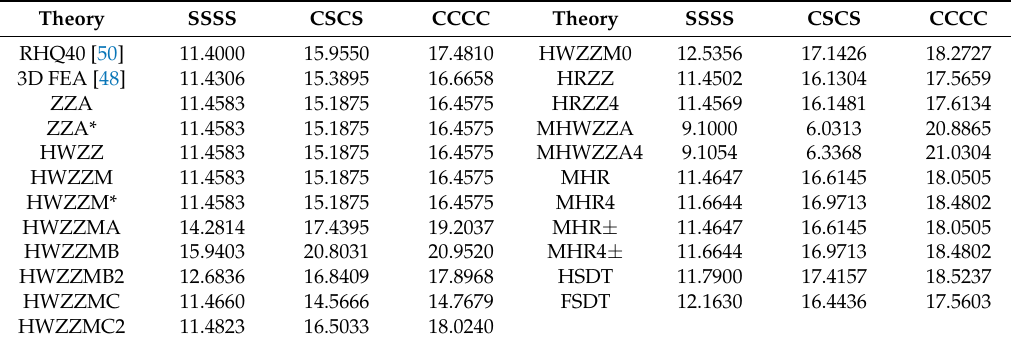
Table 11. Normalized fundamental frequencies, case